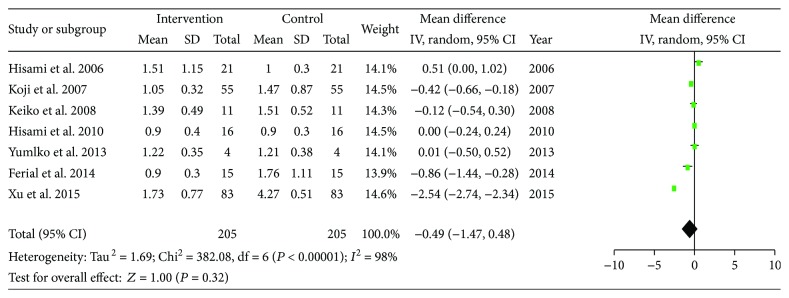
Forest plot for TB.